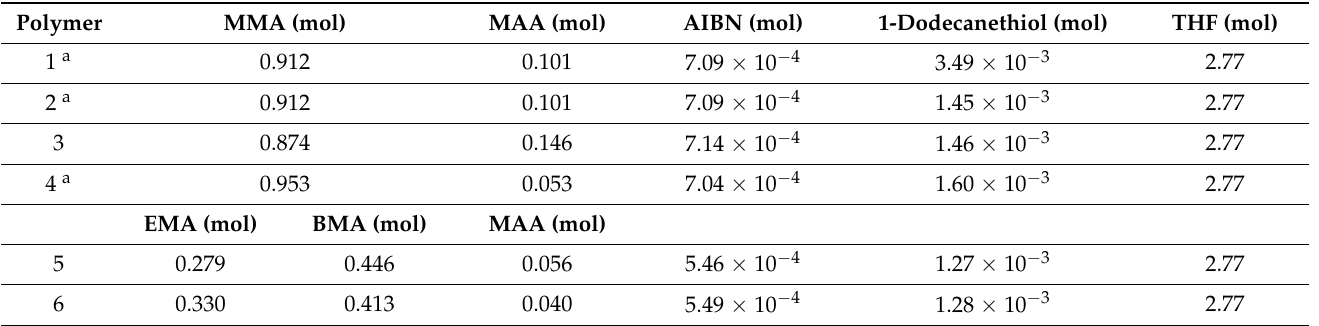
Table 1. Molar quantities of monomers, initiator (AIBN) and chain transfer agent (1-dodecanethiol) used for synthesis of Polymers